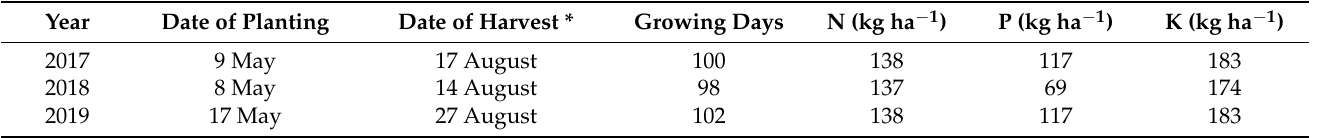
Table 2. Transplanting and harvest dates, and fertilisation by the three different years.